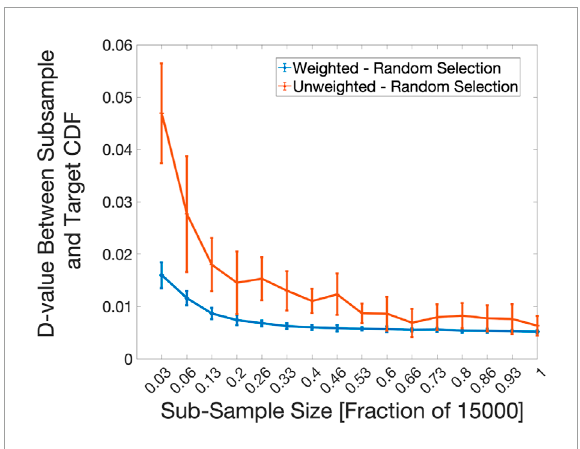
FIGURE 5 D-value versus sub-sample size trend for constitutive model. A comparison between a random sub-sample selection with PLOW applied after the selection (Weighted) and one without PLOW applied (Unweighted) is shown. At each X -axis interval, 100 2-Sample K-S statistic values (D-values) were calculated between the target distribution and a proposal distribution constructed using a different drawing of points from the pool of 15,000 total input points. The average and standard deviation of 100 D-values is plotted at each sub-sample size value.